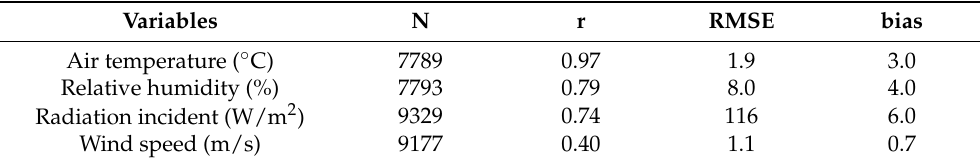
Table 2. Statistics of the comparison between ERA-Interim reanalysis and the measures of the meteorological stations of the Tensift Observatory network at the time of the Terra satellite